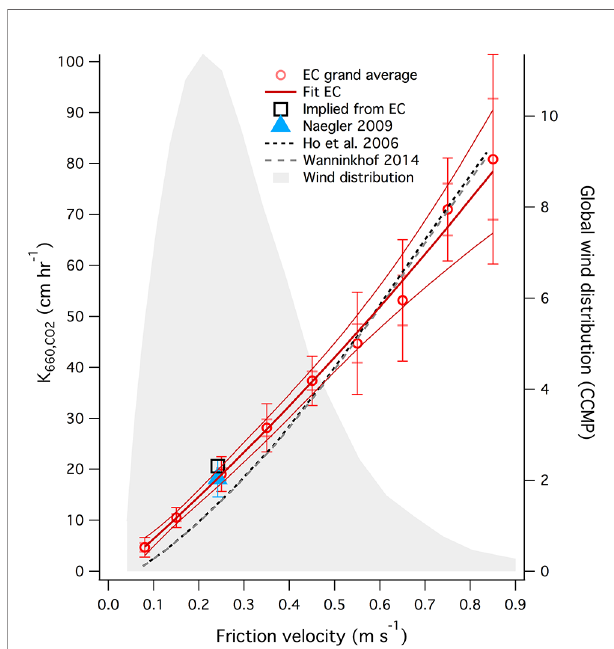
FIGURE 8 | Grand average of EC K 660 from all cruises vs. friction velocity, with the smaller (larger) error bars indicating standard error (standard deviation). The thick red line indicates the weighted polynomial fi t to this data ( K 660 = − 1 : 47 + 76 : 67 u * + 20 : 48 u 2 *), while the thin red lines are the 95% con fi dence bands for the fi t. Combining the grand average of EC K 660 with the CCMP wind distribution yields a global average K 660 , which is shown along with the Naegler (2009) estimate. Also shown are previous K 660 relationships from Wanninkhof (2014) based on 14 C disequilibrium and from Ho et al. (2006) based on the dual tracer ( 3 He/SF 6 )